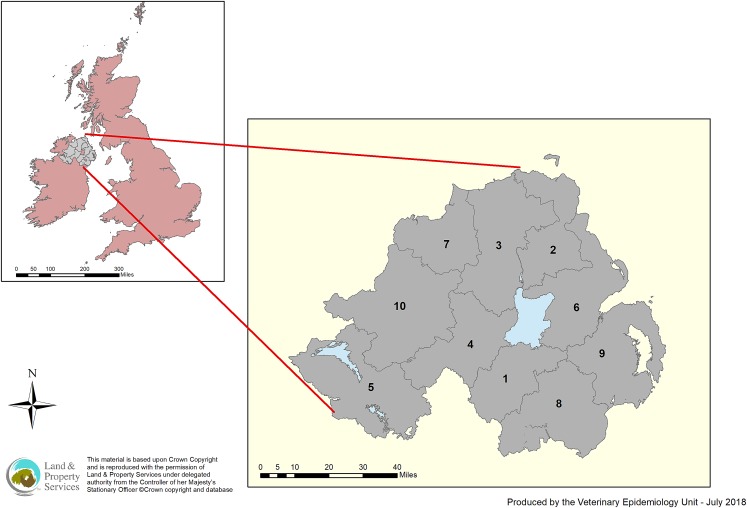
Spatial distribution of the ten Divisional Veterinary Office (DVO) areas in Northern Ireland.